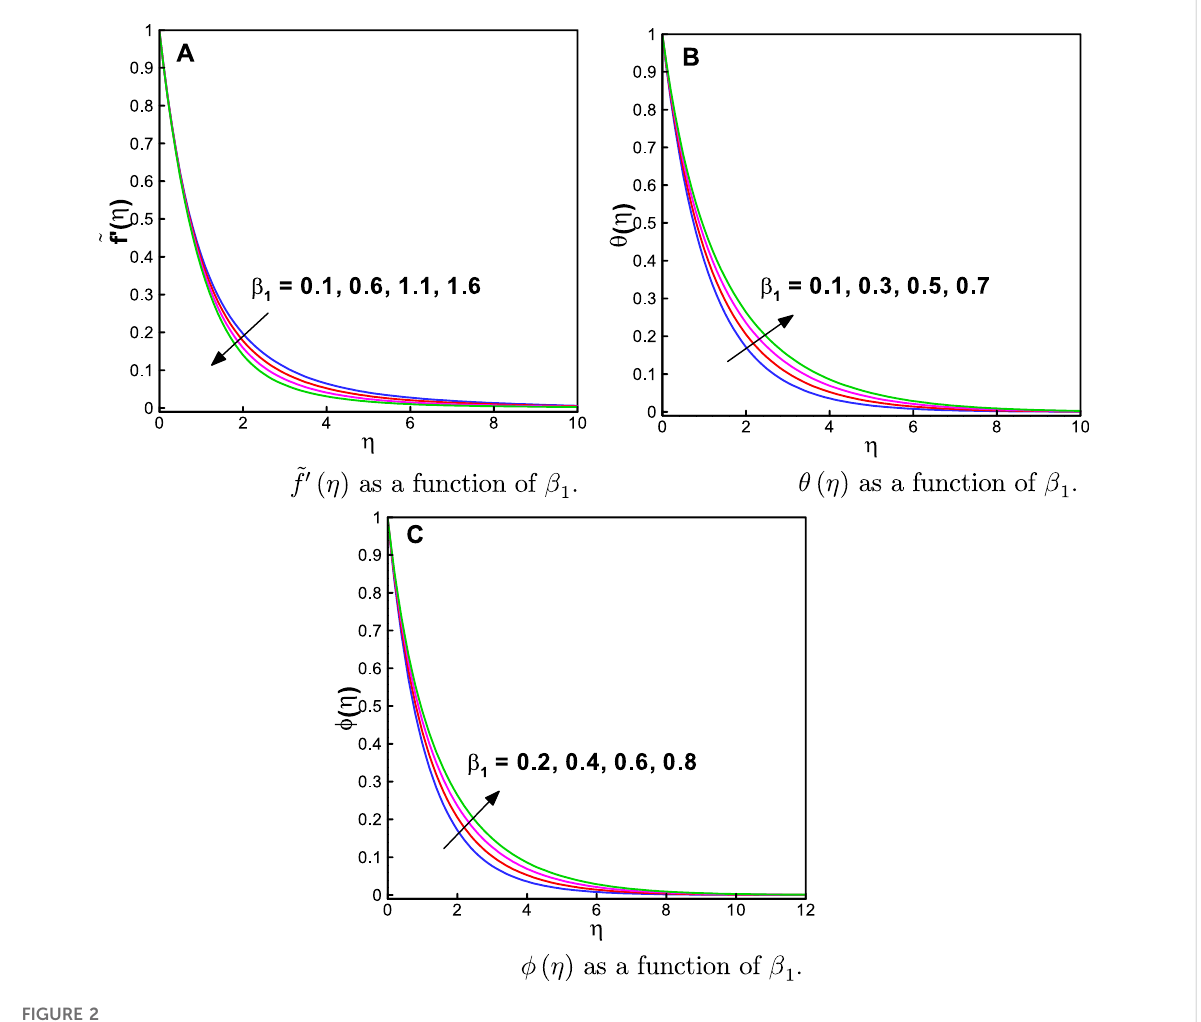
FIGURE 2 (A) ~ f ′ ( η ) as a function of β 1 . (B) θ ( η ) as a function of β 1 . (C) ϕ ( η ) as a function of β 1